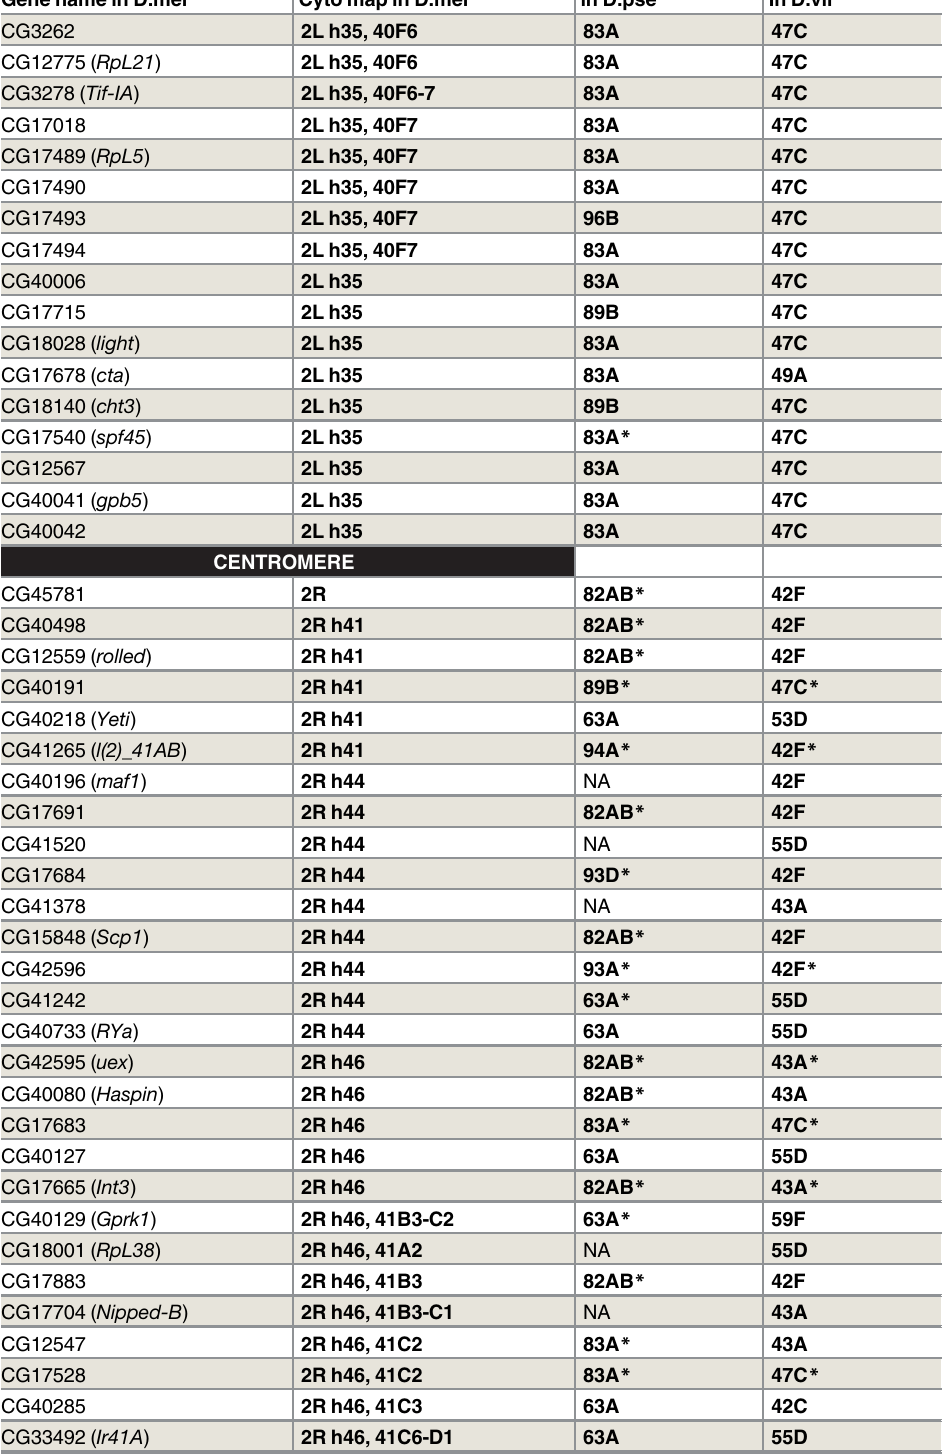
Table 1. Mapping of the analysed D . melanogaster heterochromatic genes and their orthologs in D . pseudoobscura and D . virilis . Gene name in D.mel Cyto map in D.mel in